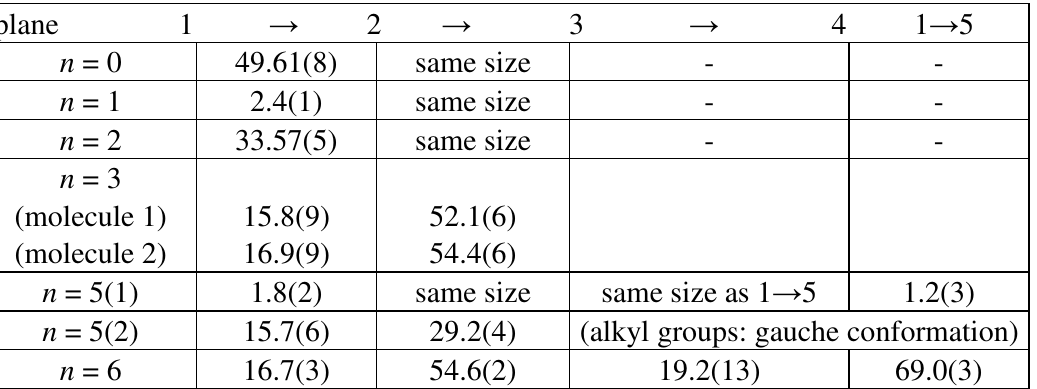
Table 9. Twist between phenyl planes as well as between phenyl plane and alkane plane of TBAA- n in degrees (plane assignment cf. Scheme 2) at ambient temperature, except TBAA-5(1) at T = 11 °C.